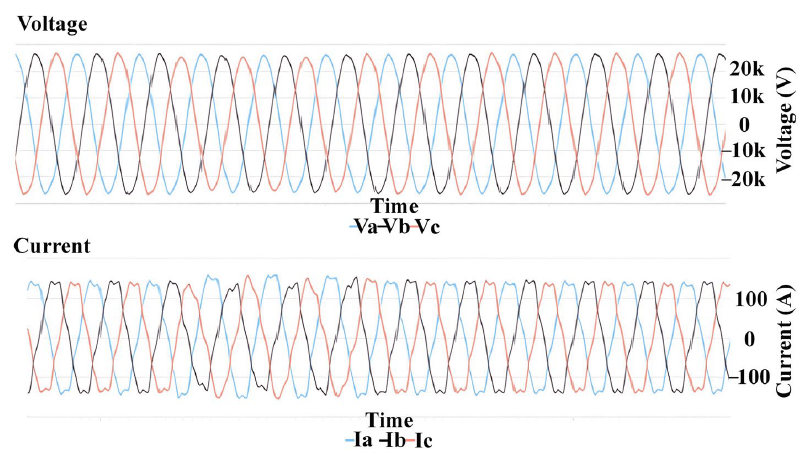
Figure A7. Current and voltage waveform recorded by PQ analyzer during the voltage sag for event 7.